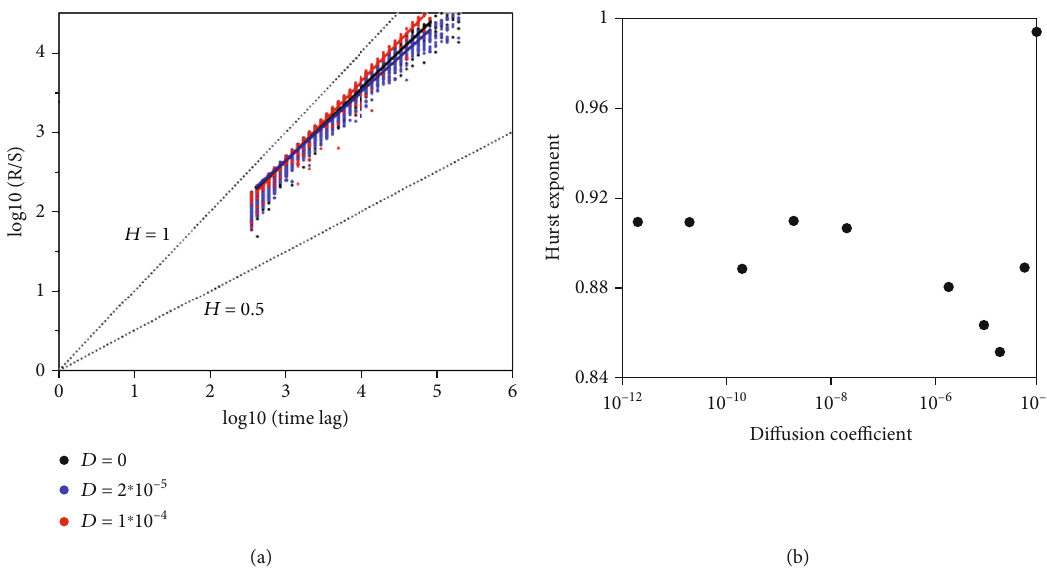
Figure 6: Self-similarity analysis of pressure fl uctuations with rescaled range analysis. (a) Rescaled range ( R / S ) versus time lag in model time steps. The slope of the curve indicates the Hurst exponent ( H , plotted in (b)). Dotted lines show H = 0 : 5 and H = 1 . (b) Hurst exponents versus D for shown data-series, including those shown in (a). For D = 0 H = 0 : 9049 , where H = 0 : 9 indicates self-organized criticality [56, 73]. With a higher di ff usion coe ffi cient, the Hurst exponent fi rst decreases, until it increases up to almost H = 1 , indicating a fully correlated time